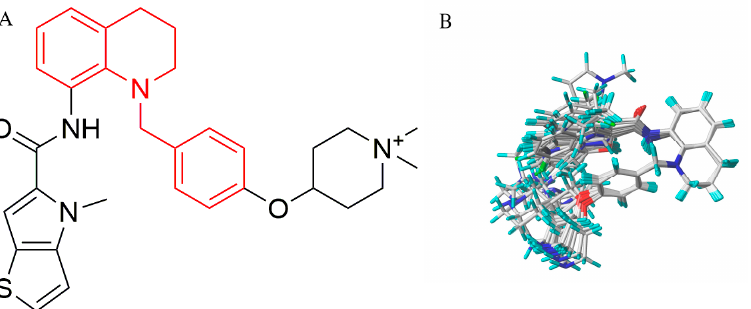
Figure 9. ( A ) That marked in red is the common skeleton of the compounds and ( B ) the alignment result of the training